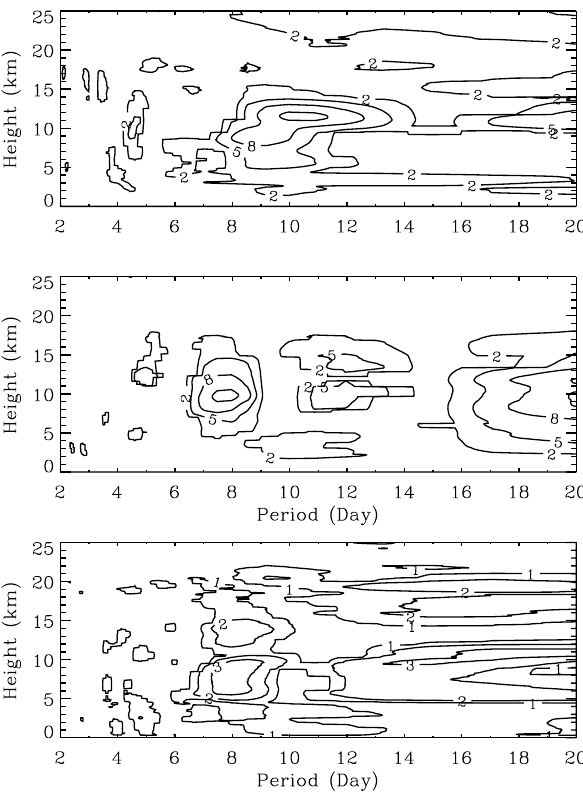
Fig. 10. Similar to Fig. 9, but in January 2007. The minimum value and the interval of the contours for the zonal wind are 2 and 3ms − 1 , respectively, for the meridional wind are 2 and 3ms − 1 , respectively, and for the temperature are all